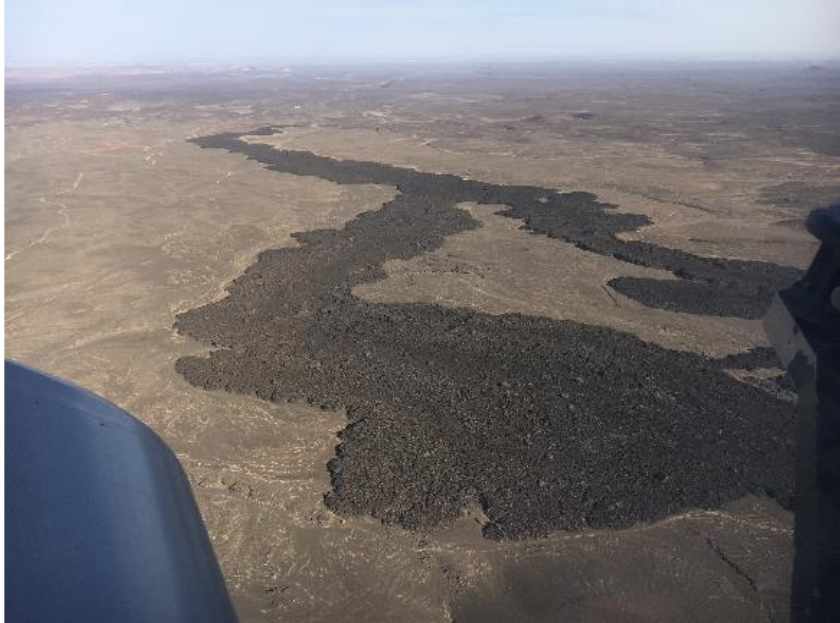
Figure 25. Completely clastic type of lava fl ow section in the distal section of a lava fl ow east of Jabal Quidr. The lava fl ow left arm is about 300 m wide. It is very clear that the fl ow movement was heavily a ff ected by the position of the microtopography. Nearly all the observed medial or distal clastic lava fl ow zones formed fl at-topped lava systems that spread across the entire available shallow channel network of the syneruptive topography. These fl ows are channelized and, by their emplacement, inferred